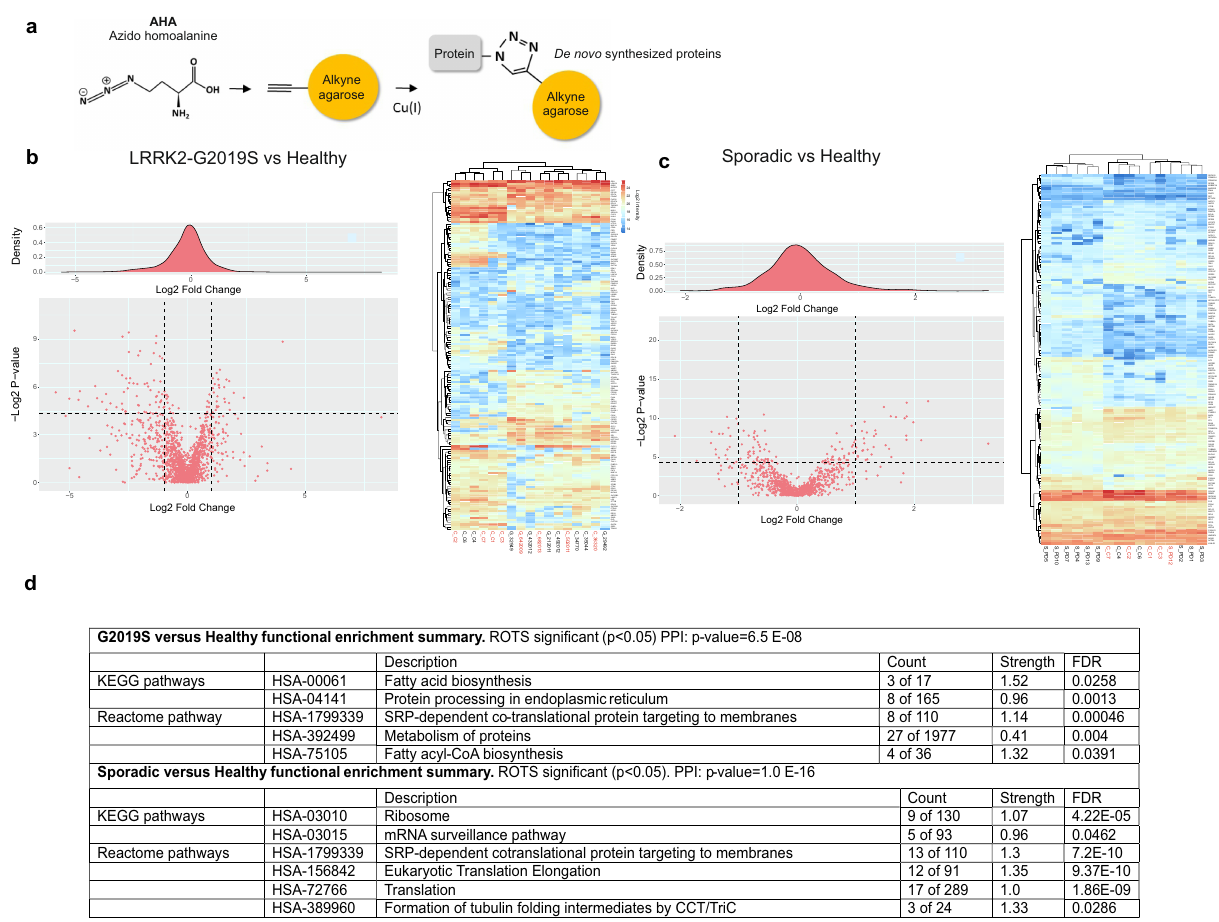
Fig. 2 De novo protein synthesis is altered in LRRK2-G2019S and sporadic PD patient fi broblasts versus healthy controls. a Schematic overview of click reaction used to isolate newly synthesized proteins. b Volcano plot of all AHA-labeled protein intensities for LRKK2-G2019S versus healthy. ROTS p -values are depicted. Heat-map with K-means hierarchical clustering depicts the signi fi cantly regulated nascent protein intensities in fi broblasts from LRRK2-G2019S patients versus healthy individuals. The union of ROTS and t -test with p -value < 0.05 are shown. Red sample label indicates female gender. Proteins are labeled with their corresponding gene names as they are more concise. c Volcano plot of all AHA-labeled protein intensities for sporadic versus healthy using ROTS statistical test, and heatmap with hierarchical clustering depicts the nascent proteins as in b above. d Proteins with intensity fold change > 1.5 and ROTS p -value < 0.05 were analyzed in STRING. Top ranking (by FDR or count in network) functional enrichments for KEGG pathways and Reactome pathways are shown. Strength is calculated from log 10 (observed/expected) network proteins. FDR shows p -values corrected for multiple testing using the Benjamini-Hochberg